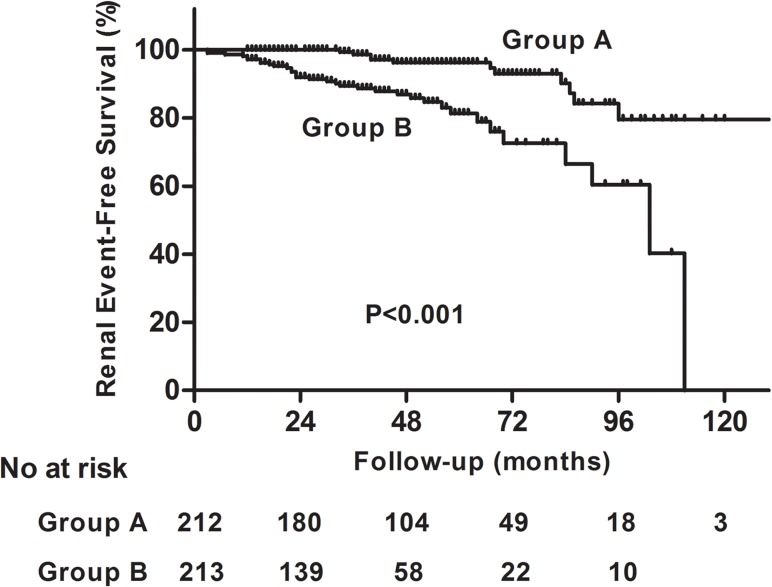
Kaplan-Meier renal survival curves of IgAN patients according to urinary CXCL1 levels.Patients with IgAN were divided into two groups, according to the median urinary CXCL1 level (18.29 pg/mg). Those with CXCL1 levels less than 18.29 pg/mg were classified as group A, while others (CXCL1 levels above 18.29 pg/mg) were classified as group B. IgAN patients in group B had significantly lower renal survival rate than those in group A (P < 0.001). The renal survival at first and fifth year for patients in group A were 100.0% and 96.3%, while for patients in group B were 97.2% and 81.3% (Log Rank test, p<0.001).